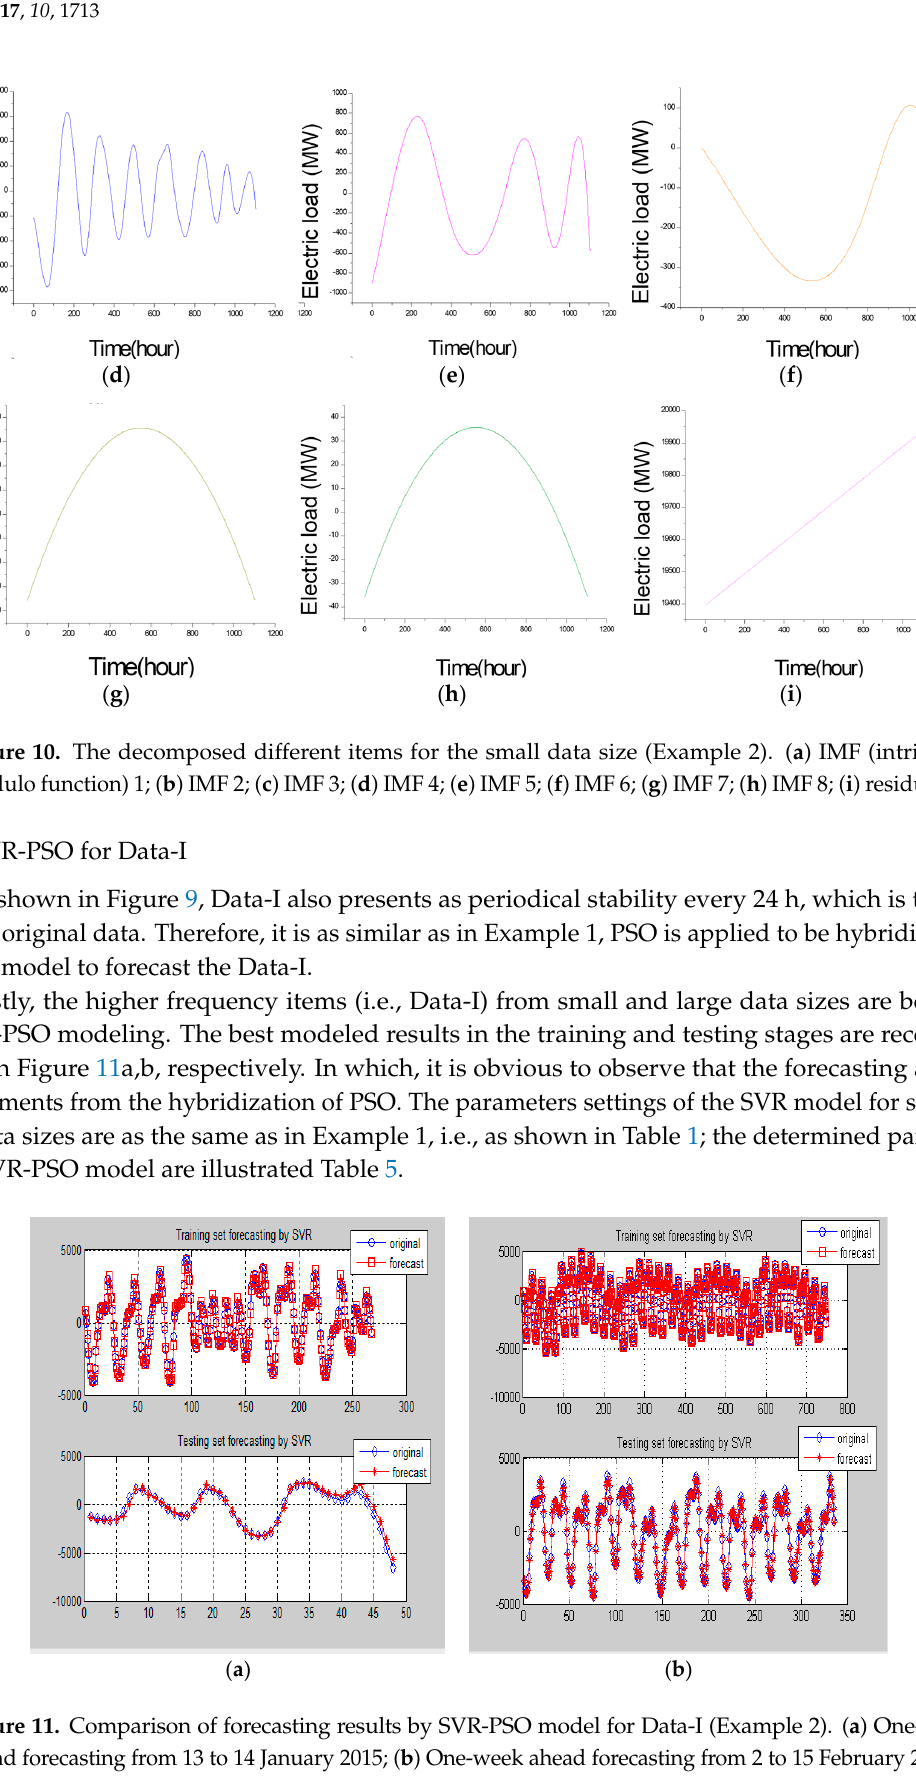
Figure 11. Comparison of forecasting results by SVR-PSO model for Data-I (Example 2). ( a ) One-day ahead forecasting from 13 to 14 January 2015; ( b ) One-week ahead forecasting from 2 to 15 February 2015.